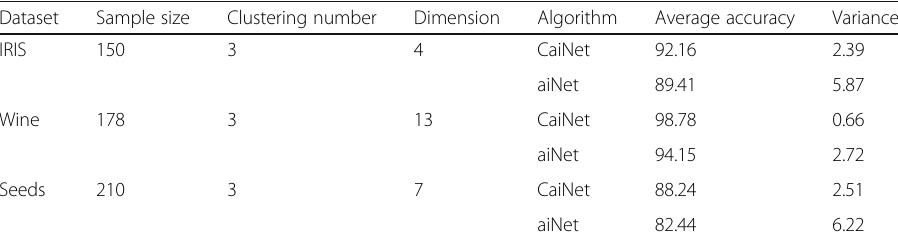
Table 1 Comparison of clustering performance between the two algorithms for three